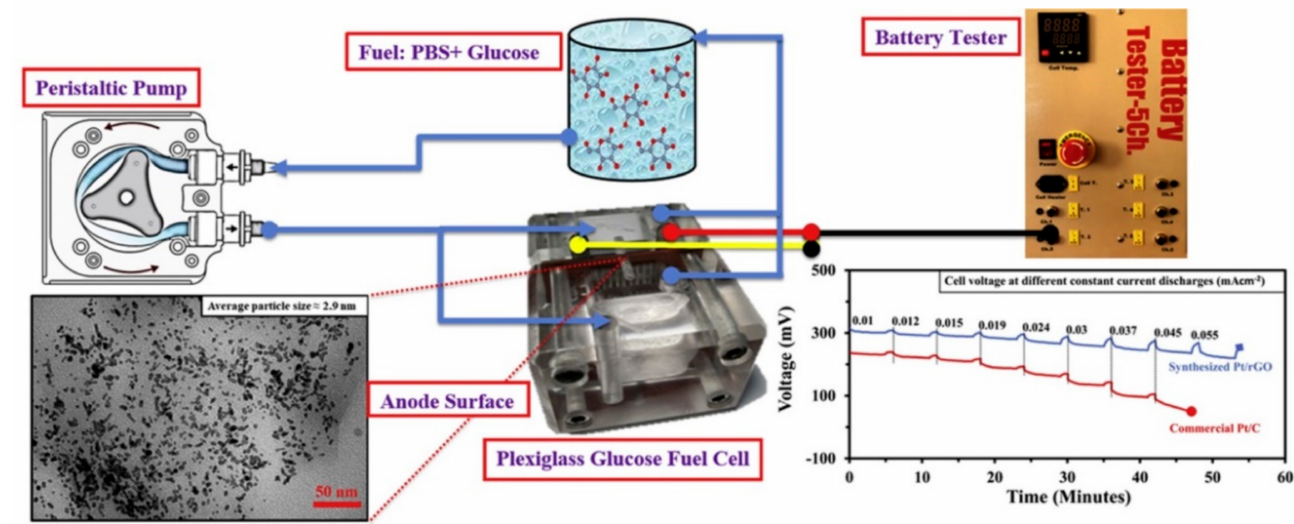
Figure 4. Schematic description of the nanozyme-based glucose biofuel cell system showing the potential to be utilized as a power source within implantable devices. Reprinted with permission from ref. [53]. Copyright 2020